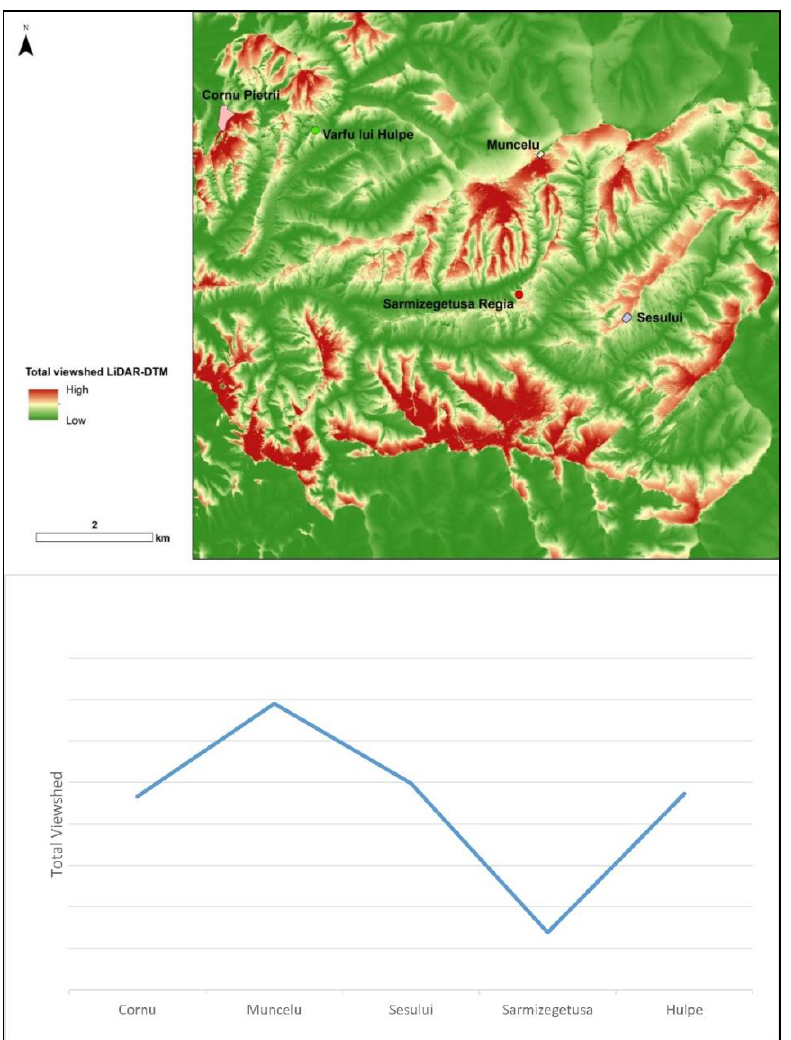
Figure 6. Total viewshed analysis within the study area based on the LiDAR-generated DTM as map ( above ) and as relative statistical values ( below ).